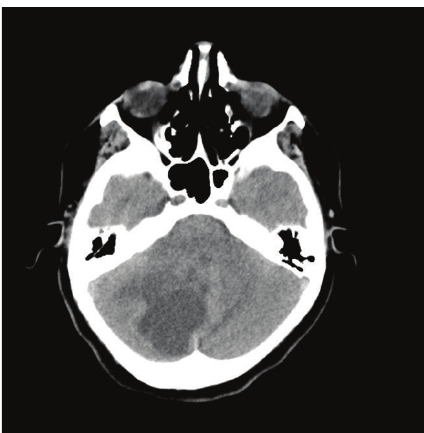
Figure 1: The preop CT scan showed a right cerebellar hypodens lesion.